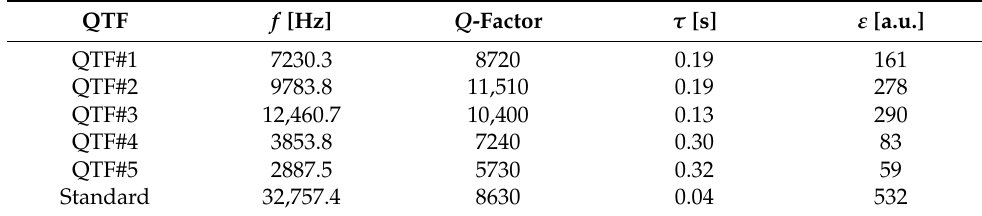
Table 1. The characteristic parameters of the used six QTFs. f : measured resonance frequency of the fundamental mode; Q -factor: related quality factor; τ : accumulation time; ε : maximum strain field. Reproduced with permission from Ref. [127]. Copyright 2020, copyright The Optical Society.